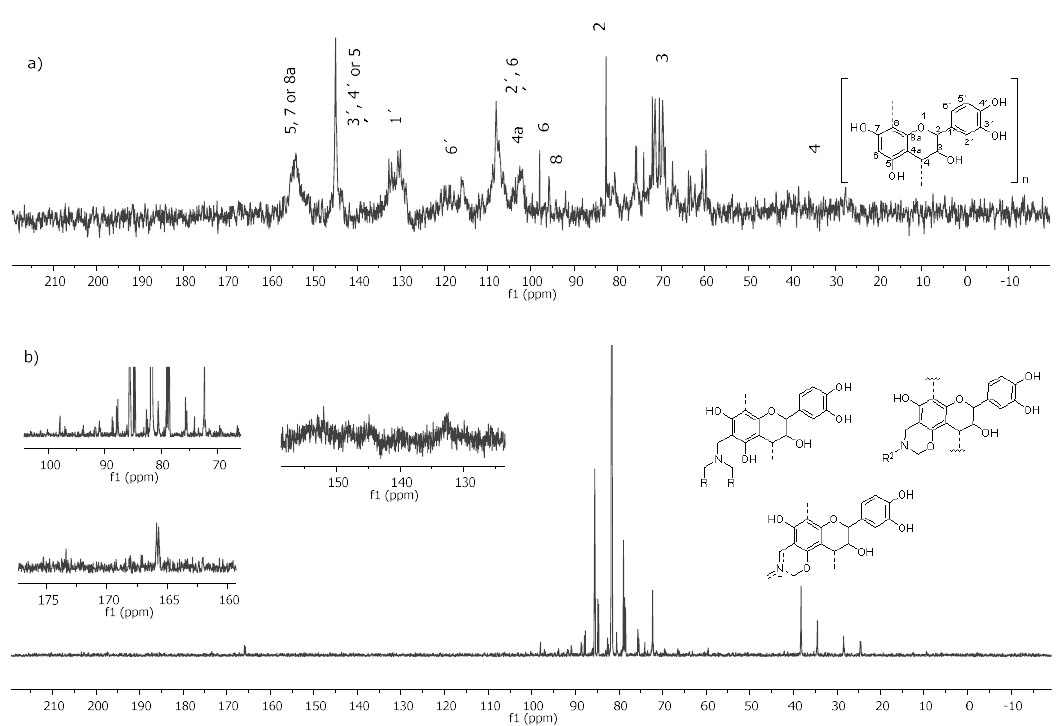
Figure 3. 13 C-NMR spectra of Acacia tannin (AT) and the modified Acacia tannin (MAT).